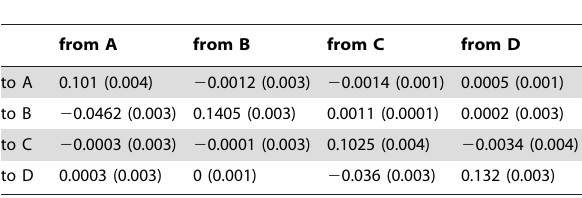
Table 3. Mean connectivity values for the 4 population